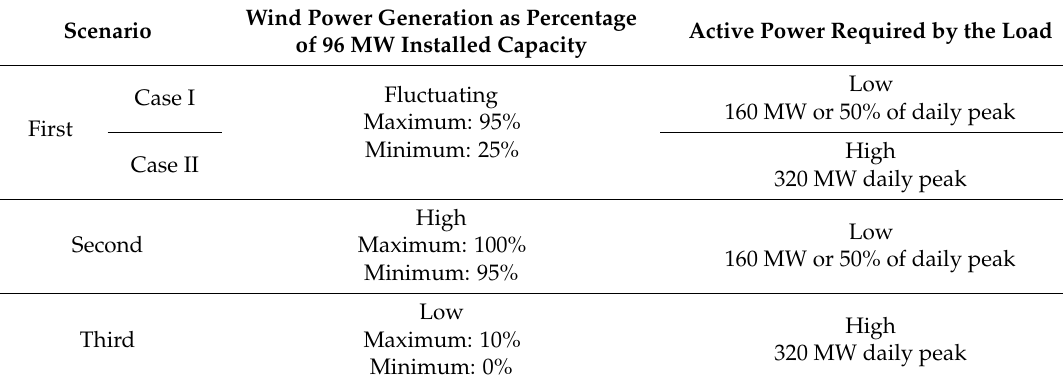
Table 1. Simulation scenarios for a system with 30% wind power penetration